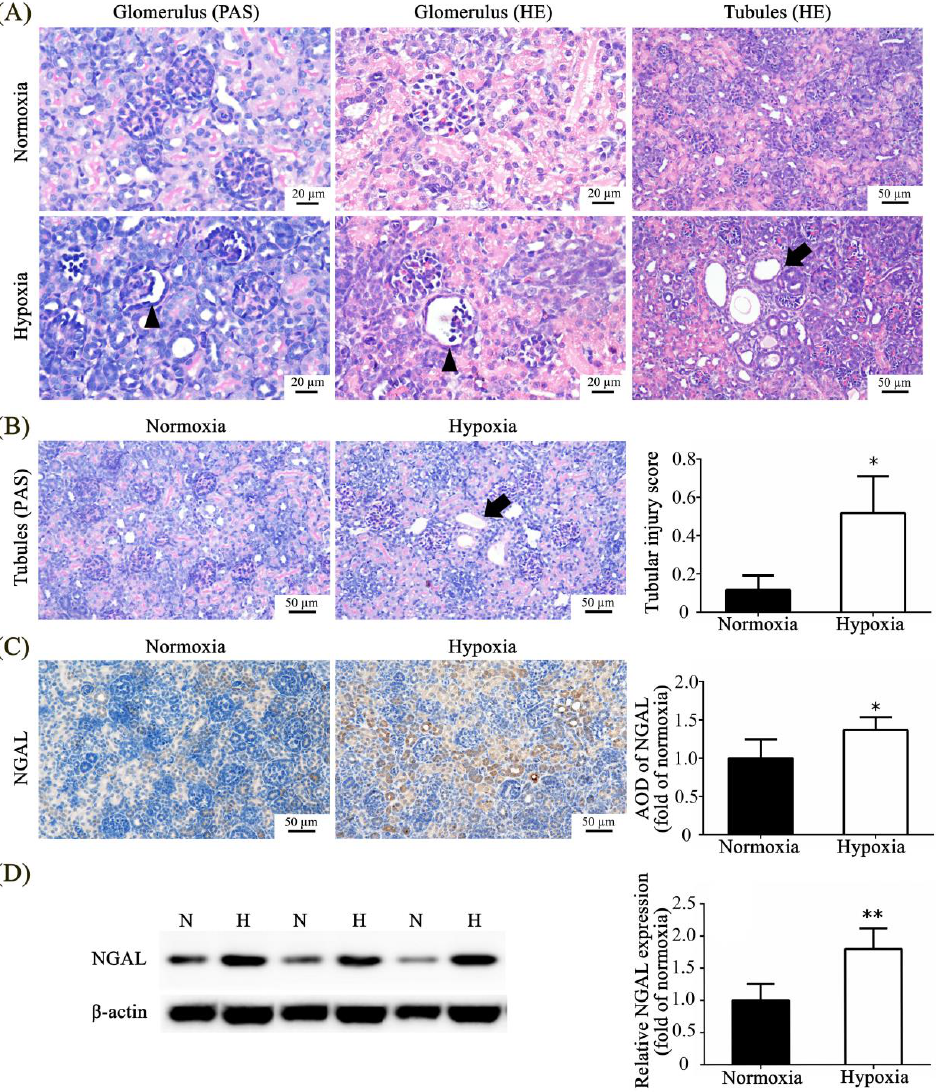
Figure 2. Neonatal hypoxia-induced glomerular and tubular injuries on postnatal day 7. ( A ) Repre- sentative PAS- and HE-stained images of the glomerulus (arrow head) under 400 × magnification (scale bar, 20 µ m) and representative HE-stained images of tubules (arrow) under 200 × magnification (scale bar, 50 µ m) in the kidneys. ( B ) PAS staining images show the tubules (arrow) under 200 × magnification (scale bar, 50 µ m) and the tubular injury score. Immunohistochemical staining ( C ), immunoblotting ( D ), and quantitative analysis of NGAL. The values are presented as mean ± standard deviation, * p < 0.05, ** p < 0.01 versus the normoxic group. The p -values were estimated via Mann – Whitney U test ( n = 6). N, normoxia; H, hypoxia; PAS, periodic acid Schiff; HE, hematoxylin and eosin; NGAL, neutrophil gelatinase-associated lipocalin; AOD, average optical density.